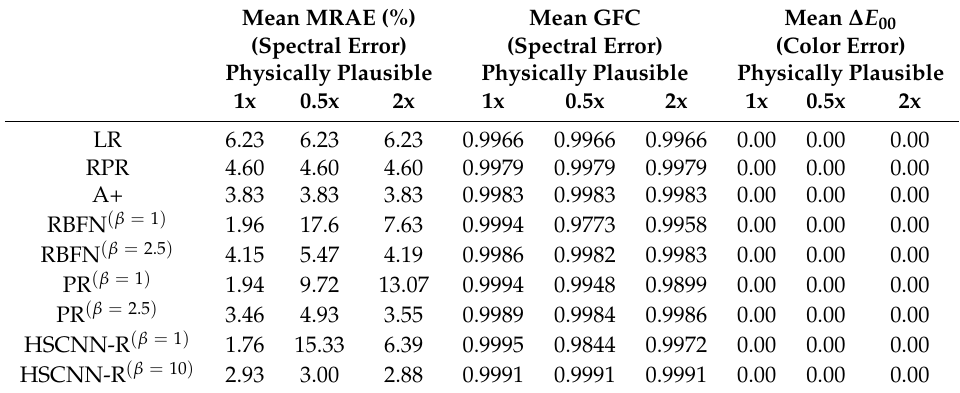
Table 4. The spectral and color accuracy of the “physically plausible” SR under original ( 1x ), half ( 0.5x ) and double exposure settings ( 2x ). The results are shown in mean MRAE, mean GFC and mean ∆ E 00 .